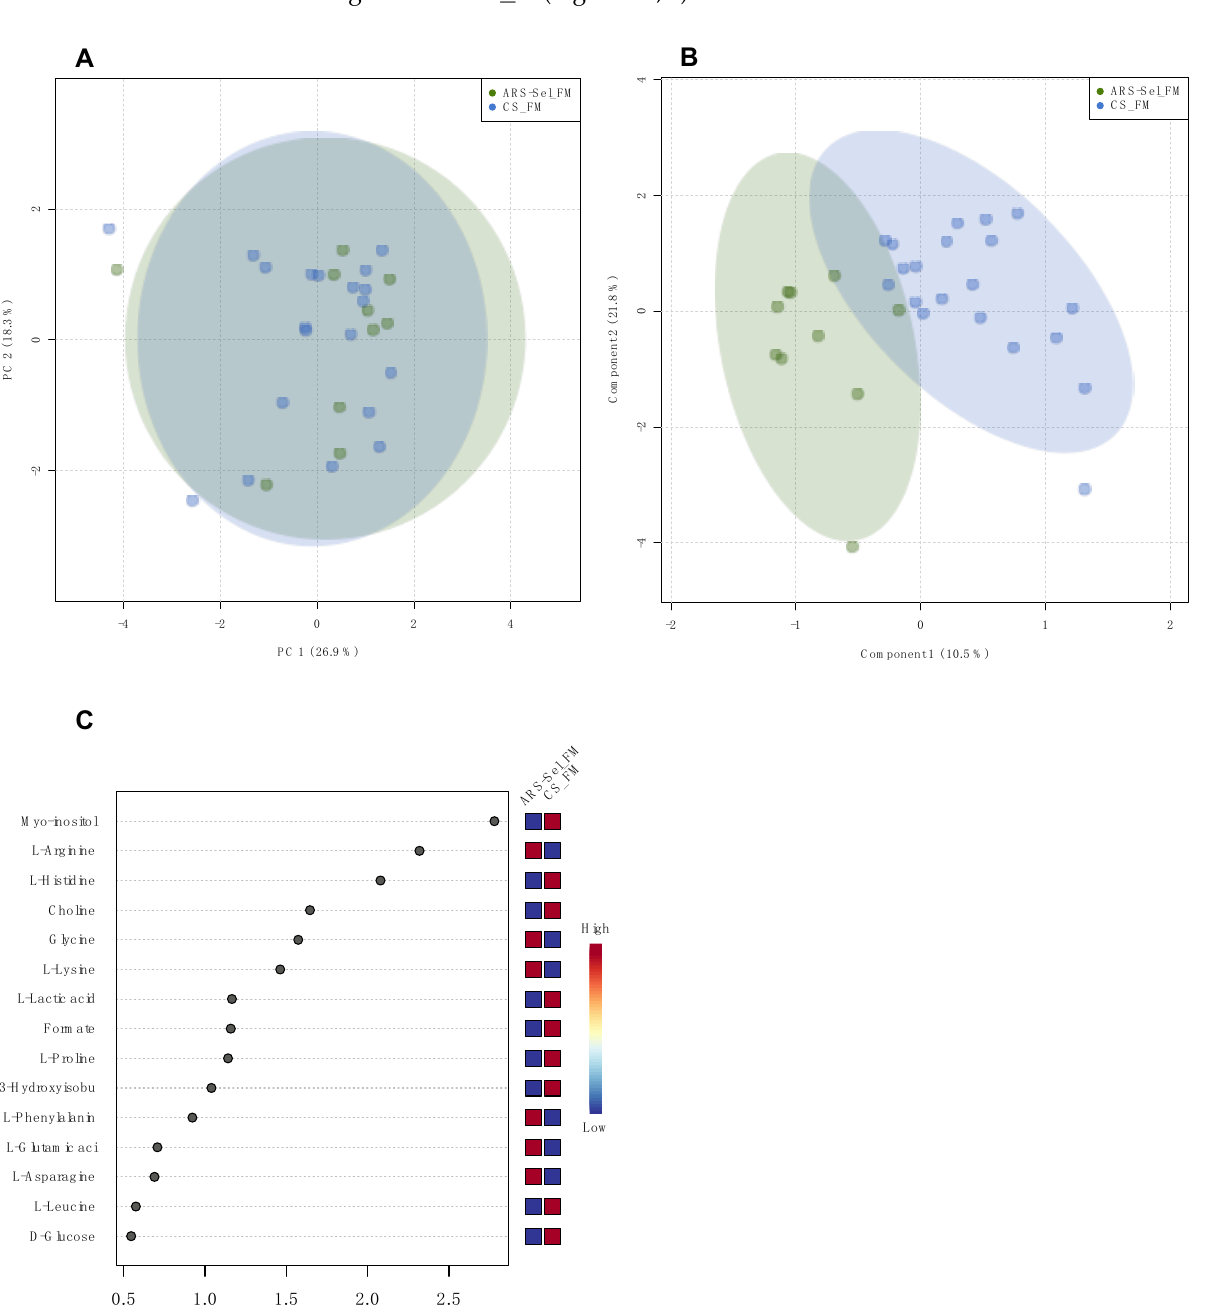
Figure 3. Multivariate analysis of groups ARS- Sel _FM and CS_FM in plasma: ( A ) PCA scores plot; ( B ) PLS scores plot, model validated (NC = 3; R 2 = 0.841; Q 2 = 0.361; 1000 permutations: p = 0.04); ( C ) VIP of the PLS scores plot model.